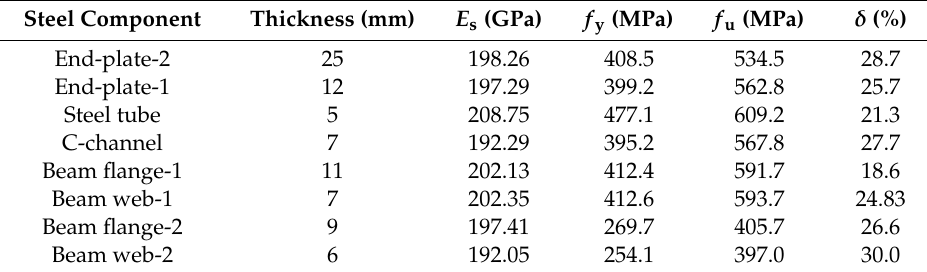
Table 2. Uniaxial tensile test results of the steel components.